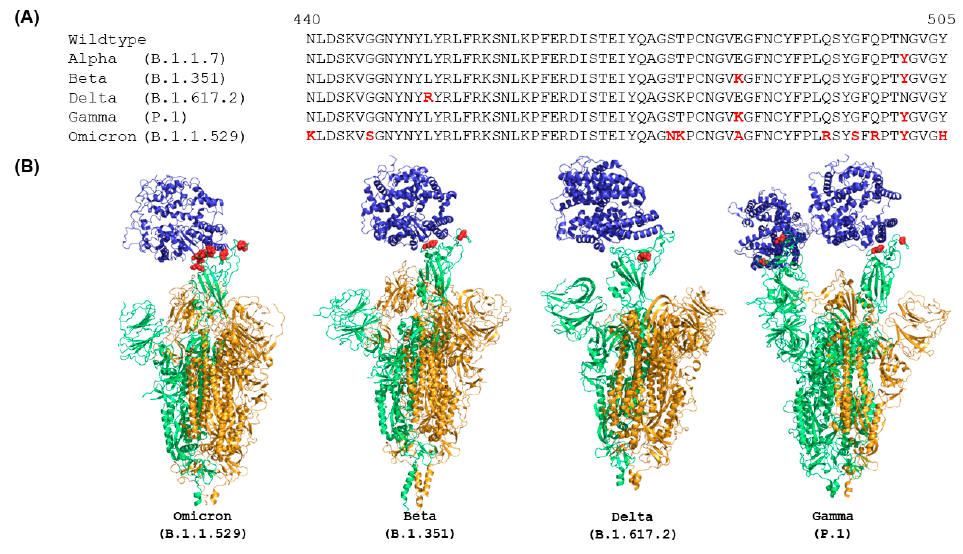
Figure 1. Comparison of RBD sequences ( A ) and ACE2-bound complex structures ( B ) of spike proteins of wild type and VOCs. Sequences are obtained from Yin et al. [16], and the sequence alignment was performed using ClustalW. The mutations in RBD are color coded in red. The human ACE2 are plotted in blue. Green and orange colors represent the chains with RBD in up and down conformations, respectively. The structures plotted in this figure were characterized by EM at the highest resolution and were obtained from PDB (7WPA for Omicron, 7VXD for Beta, 7TEX for Delta, and 7V81 for Gamma).